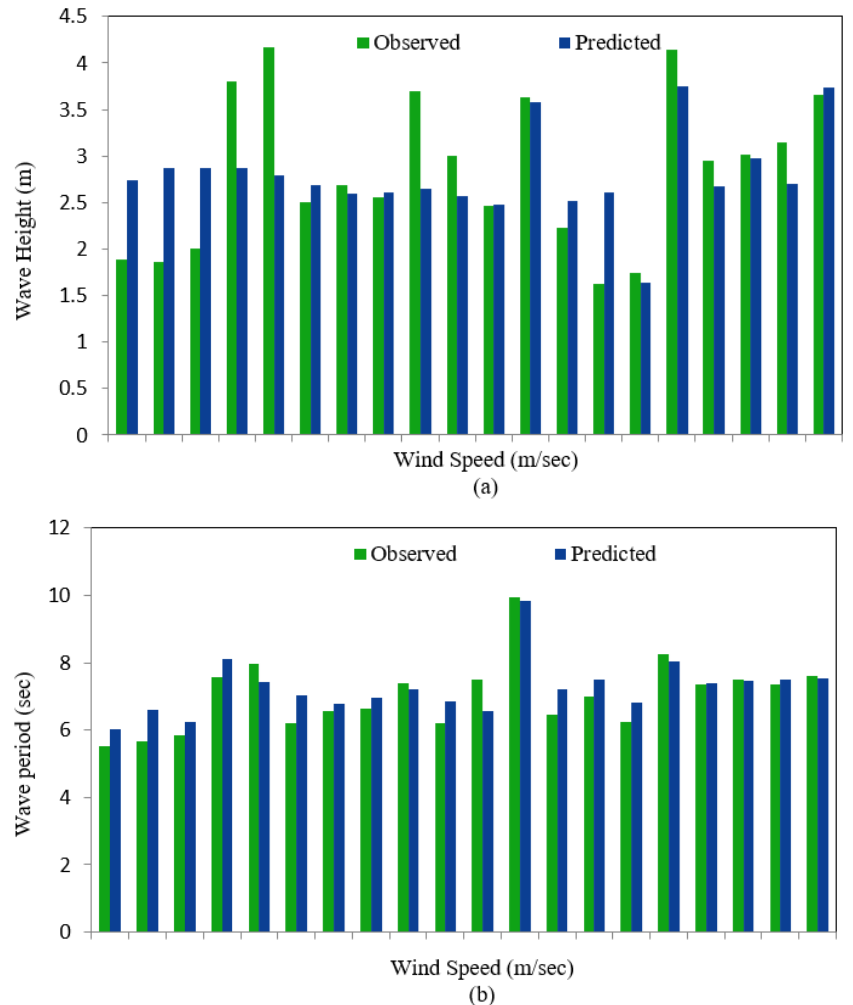
Figure 5. Variation in observed and predicted ( a ) wave height and ( b ) wave period from randomly chosen wind force.